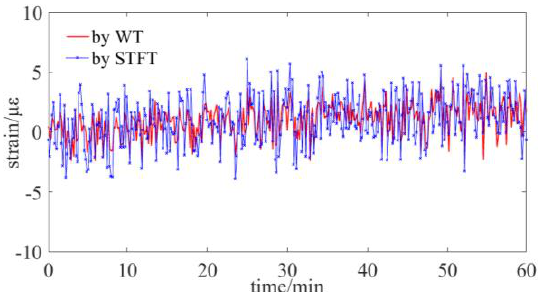
Figure 8. Experiment on the sensing stability of strain by WT and STFT.